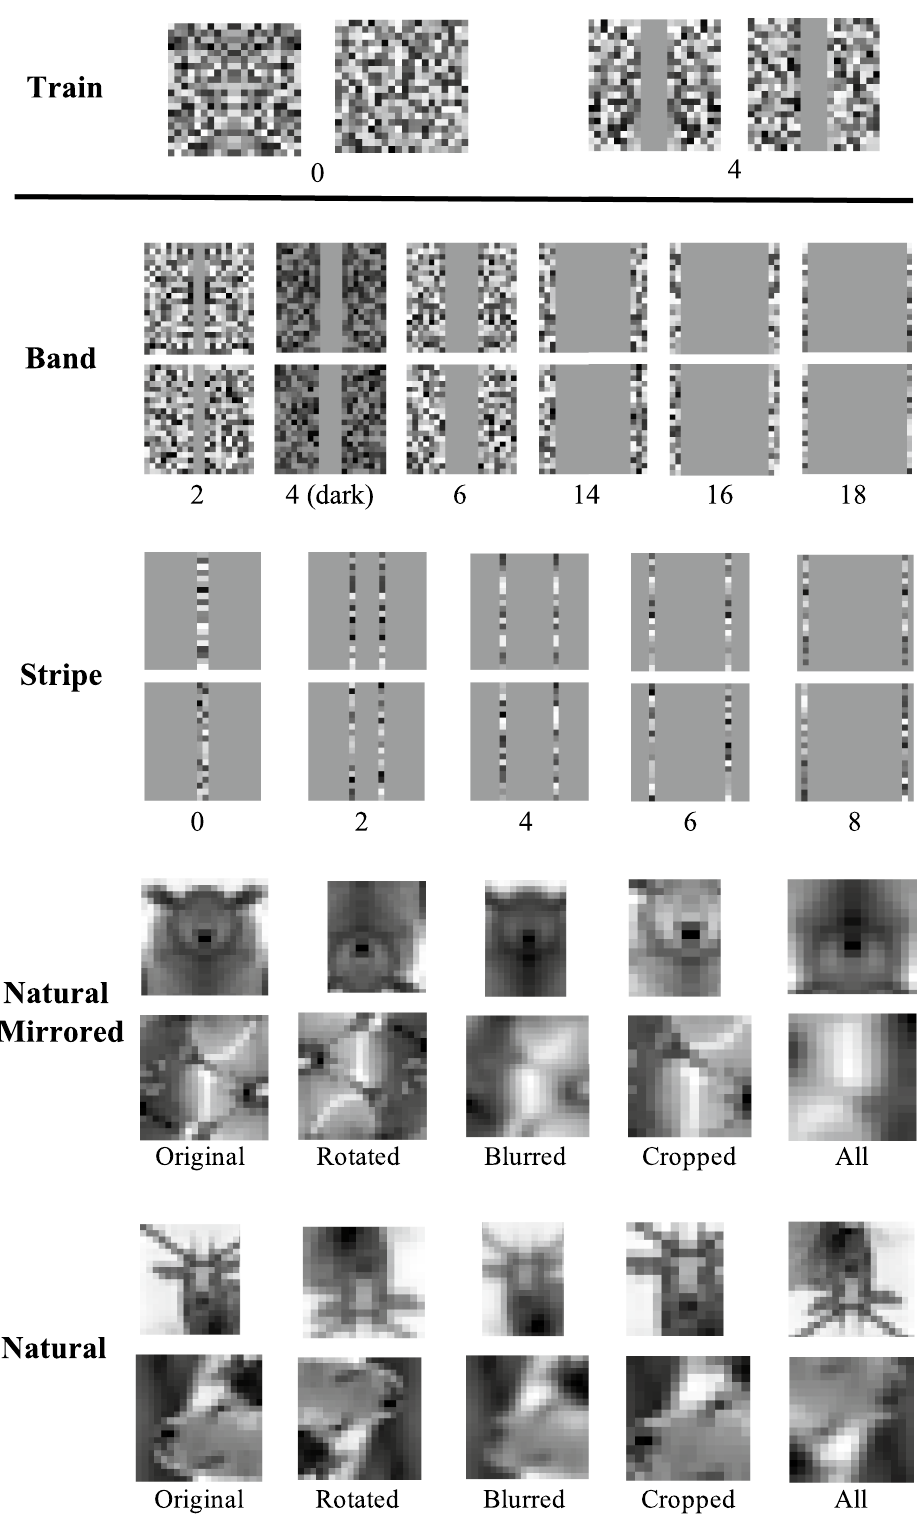
Figure 2. Datasets for evaluating learning of a general rule of symmetry detection. The test set images contain visual properties that do not appear in the training set (i.e. expanded central bands, different distances between flanks), thus enabling generalization testing. Note that in Experiment Set 1 we train only with synthetic images; in Experiment Set 2 we experiment with both synthetic and natural